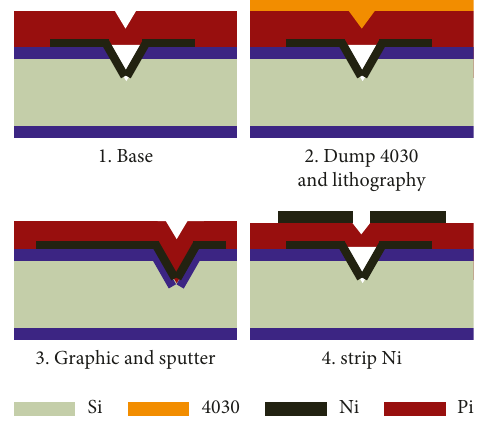
Figure 4: Process flow of electrode patterning on the micro- discharger.